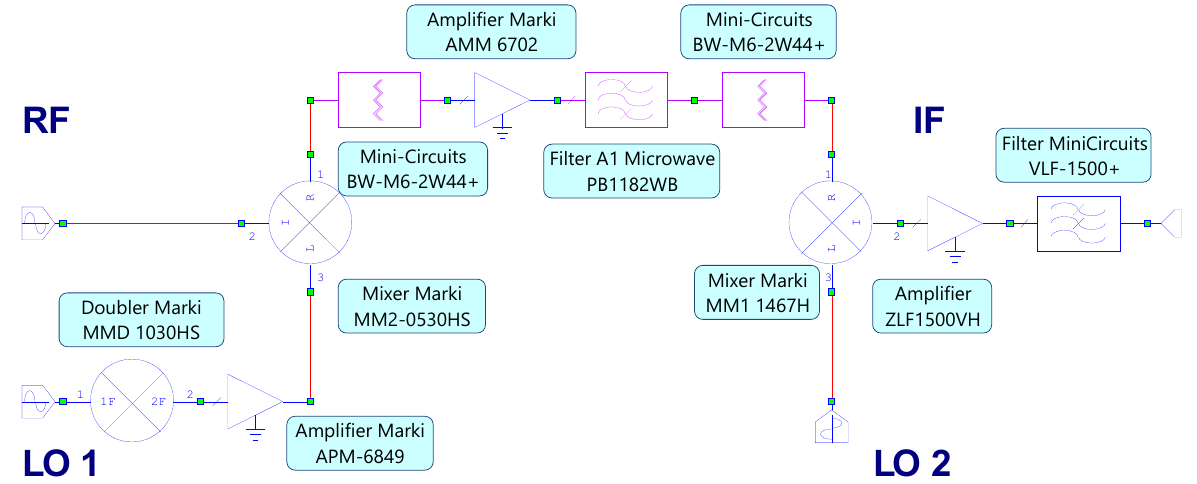
Figure 1. Schematic of the proposed microwave receiver.